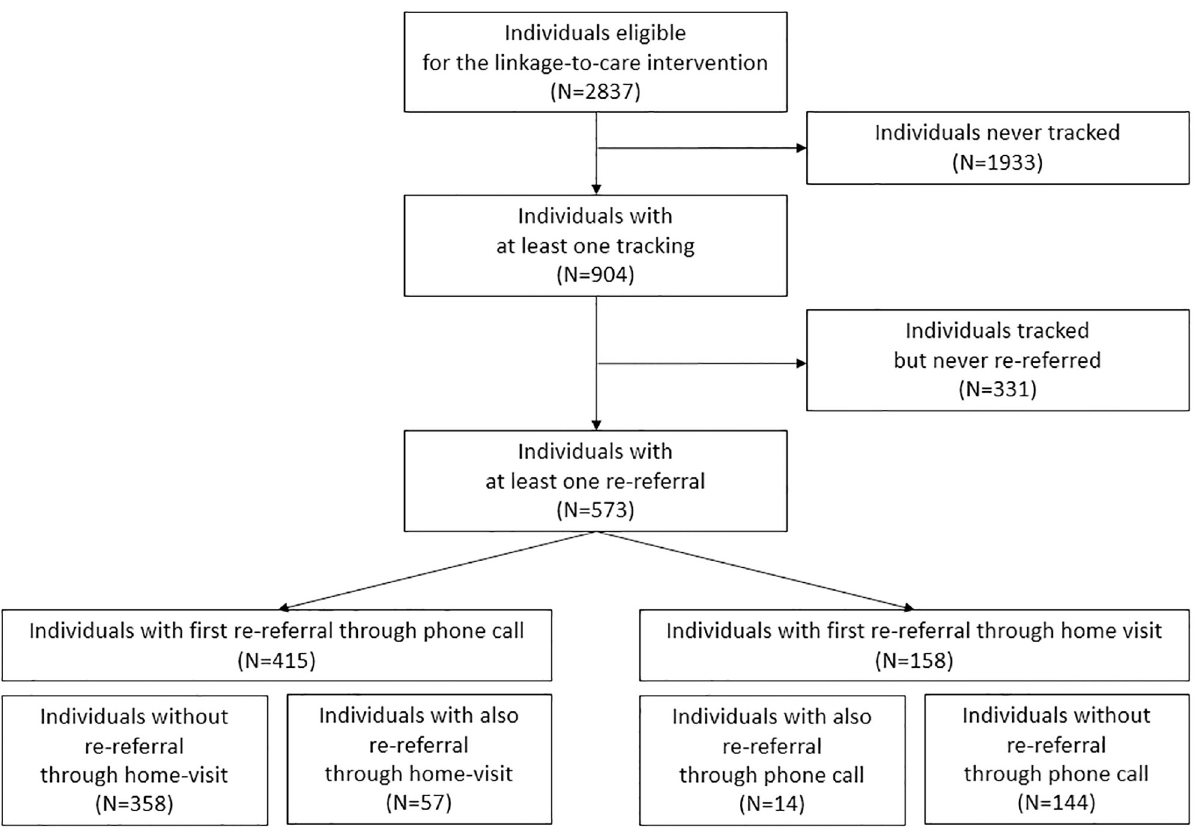
Fig 2. Crude numbers of tracking and re-referral. ANRS 12249 TasP trial. 2012–2016.